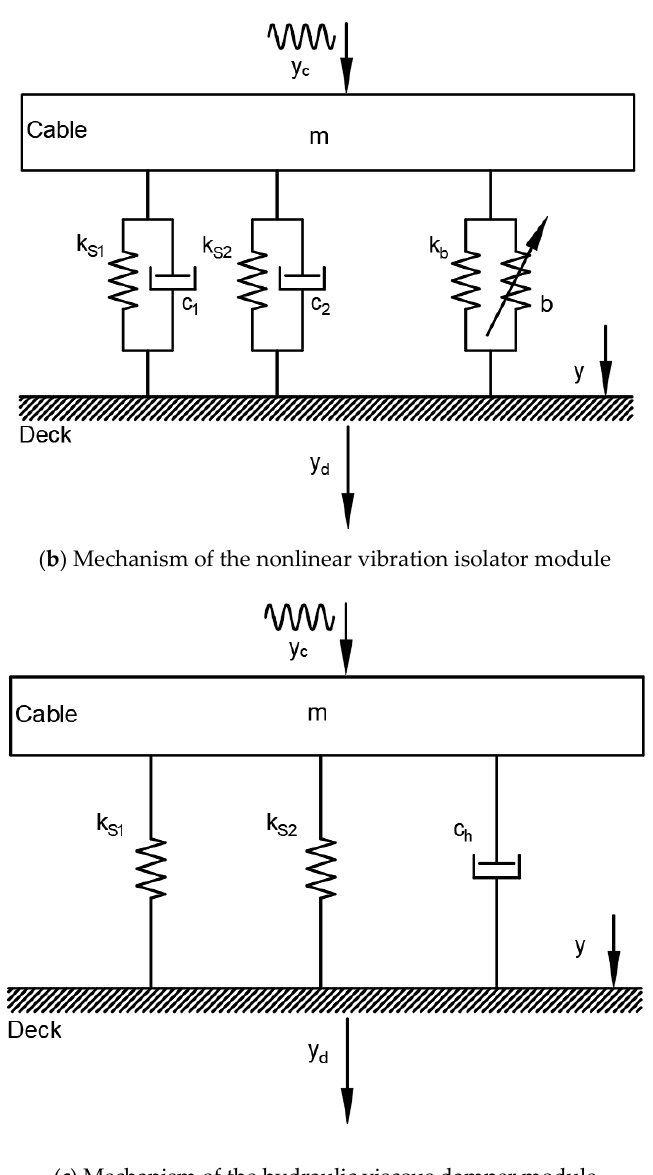
Figure 5. Simplified theoretical model of the VEAM.